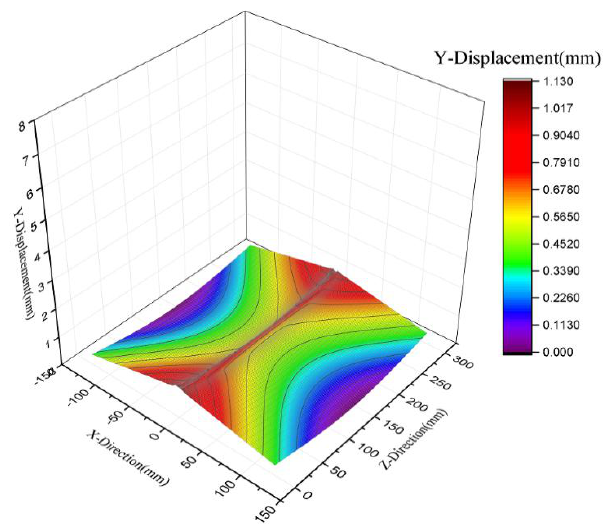
Figure 18. Three-dimensional (3D) image of welding deformation with jigs in CASE 7.